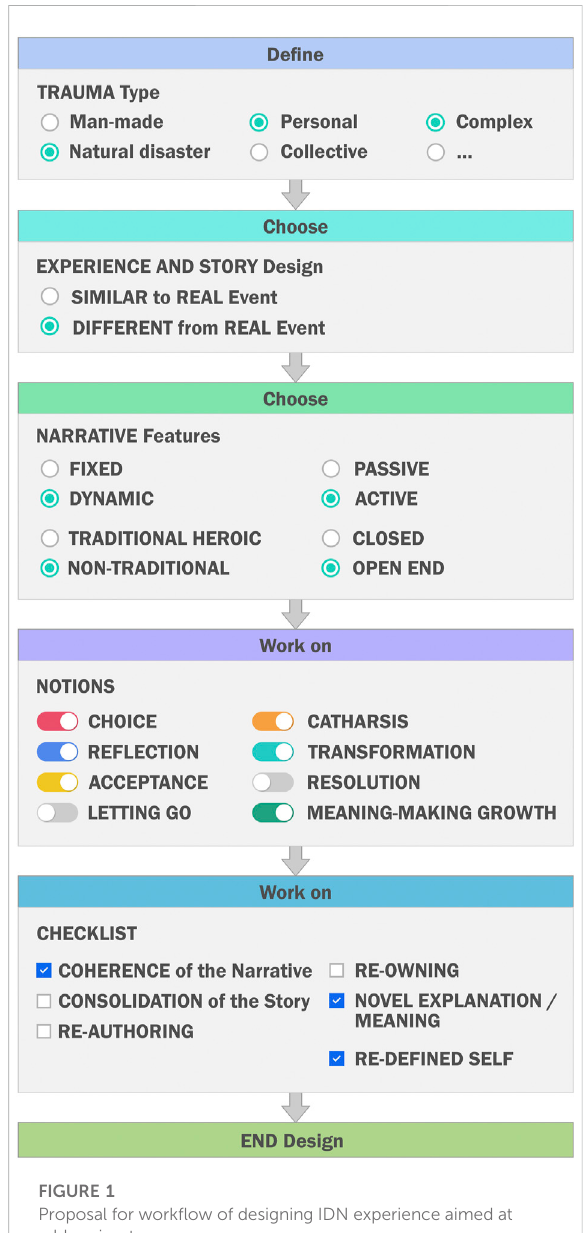
FIGURE 1 Proposal for work fl ow of designing IDN experience aimed at addressing